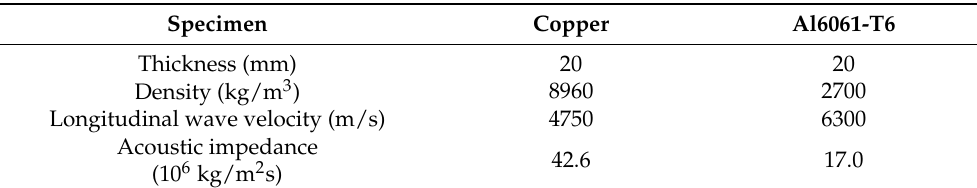
Table 1. Material properties of copper and Al6061-T6 specimens.